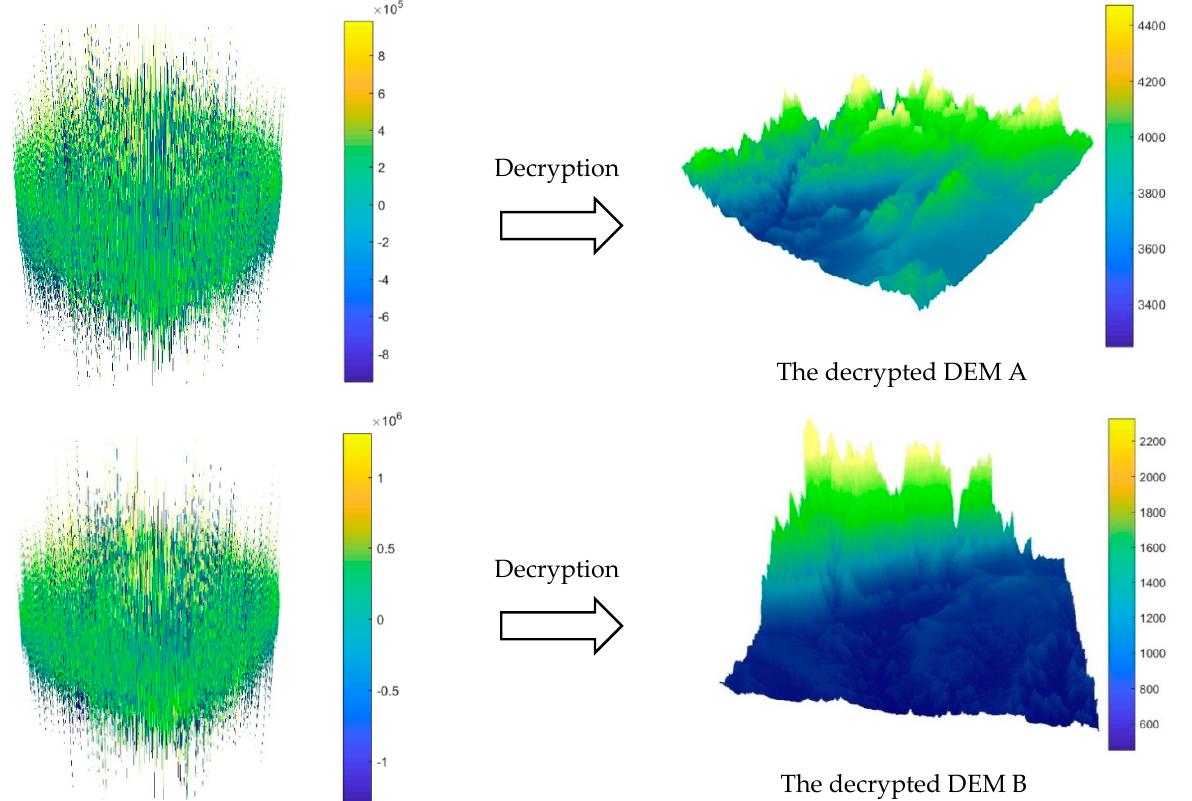
Figure 14. The decryption results of DEMs A and B with the use of true keys.